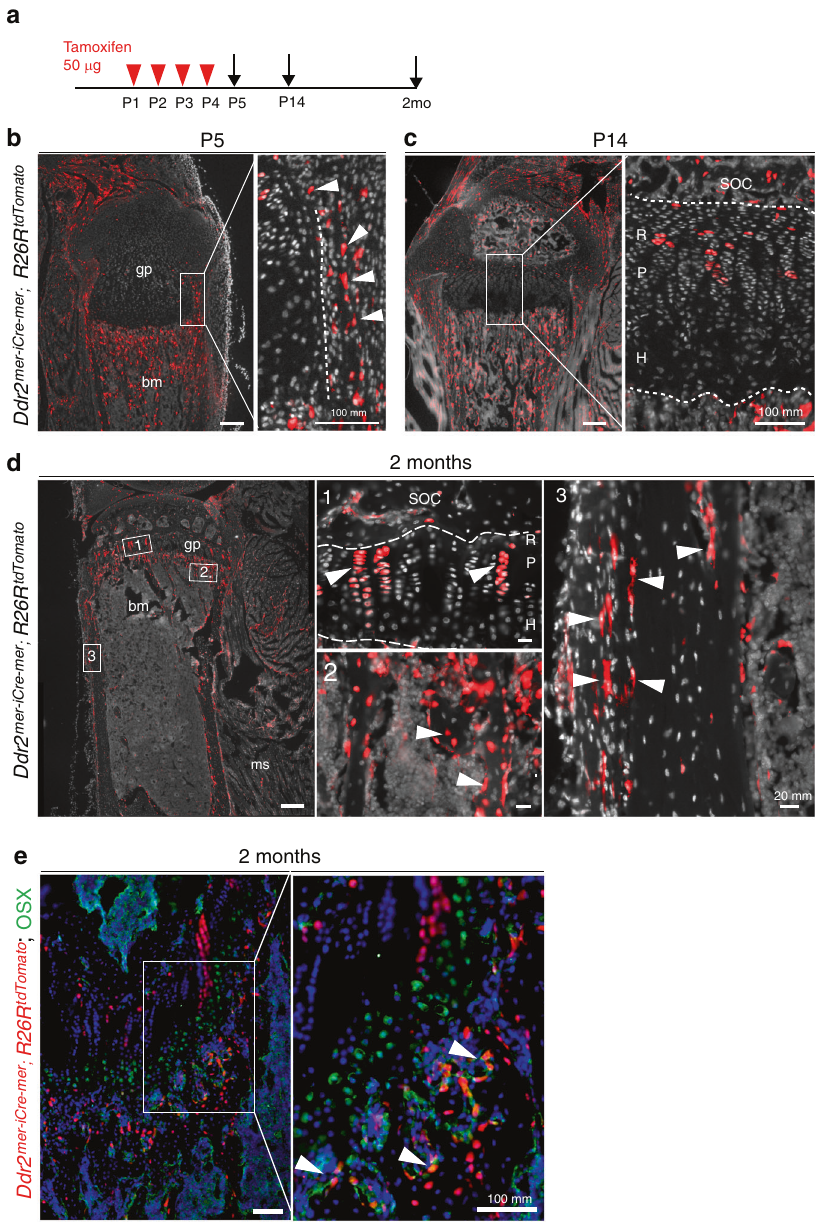
Fig. 2 Skeletal contribution of Ddr2 -expressing cells. a Protocol. b – d , Lineage tracing in Ddr2 mer-iCre-mer ; R26R tdTomato mice at the postnatal day 5 (P5), P14 and 2 months ( n = 2 mice). Red: Ddr2 -positive cells; gray: cell nuclei; gp Growth plate; bm Bone marrow; SOC Secondary ossi fi cation center; ms Muscle; R Resting zone; P Proliferative zone; H Hypertrophic zone. b Fluorescent tdTomato (red) distribution in the proximal tibia at P5 showing initial labeling in perichondrium, periosteum, primary spongiosa, and sporadic cells in the growth plate. Scale bar: 200 μ m. The boxed region is shown in higher magni fi cation (right). Arrowheads indicate expression in perichondrium. Scale bar: 100 μ m. c Fluorescent tdTomato distribution at P14 showing label in the resting and proliferative zones of growth plate and in primary spongiosa, but not in the hypertrophic zone. Scale bar: 200 μ m. Boxed region is shown in higher magni fi cation (right) Scale bar: 100 μ m. Dotted Line denotes chondro-osseous junction. d Fluorescent tdTomato distribution at 2 months showing persistence of tdTomato labeling and contribution to (1) growth plate columns, (2) bone cells in primary spongiosa, and (3) periosteum and osteocytes in cortical bone (arrowheads). Scale bar: 200 μ m. Images at a higher magni fi cation for different areas of tibia are shown on the right side. Scale bar: 20 μ m. e High power image of 2-month growth plate and trabecular regions showing co-staining of tdTomato + cells with an anti-OSX antibody (green) in osteoblasts on the trabecular surface. Scale bar: 100 μ m cells become hypertrophic chondrocytes, osteoblasts and osteo- formation in resting and proliferative zone chondrocytes, bone cytes, again consistent with Ddr2 being expressed in the early marrow, and periosteum and low or absent from terminally stages of the bone lineage. However, Ddr2 was also present in differentiated cells (e.g., hypertrophic chondrocytes and osteo- metaphyseal osteoprogenitors/osteoblasts on trabecular surfaces, cytes). This distribution at least partially overlapped with the SPC which suggests functions in more mature cells. To assess Ddr2 marker, Gli1. Furthermore, lineage tracing with Ddr2 mer-iCre-mer ; functions in speci fi c cell populations, we employed a conditional R26R -tdTomato mice showed that the progeny of Ddr2 -positive Bone Research (2022)